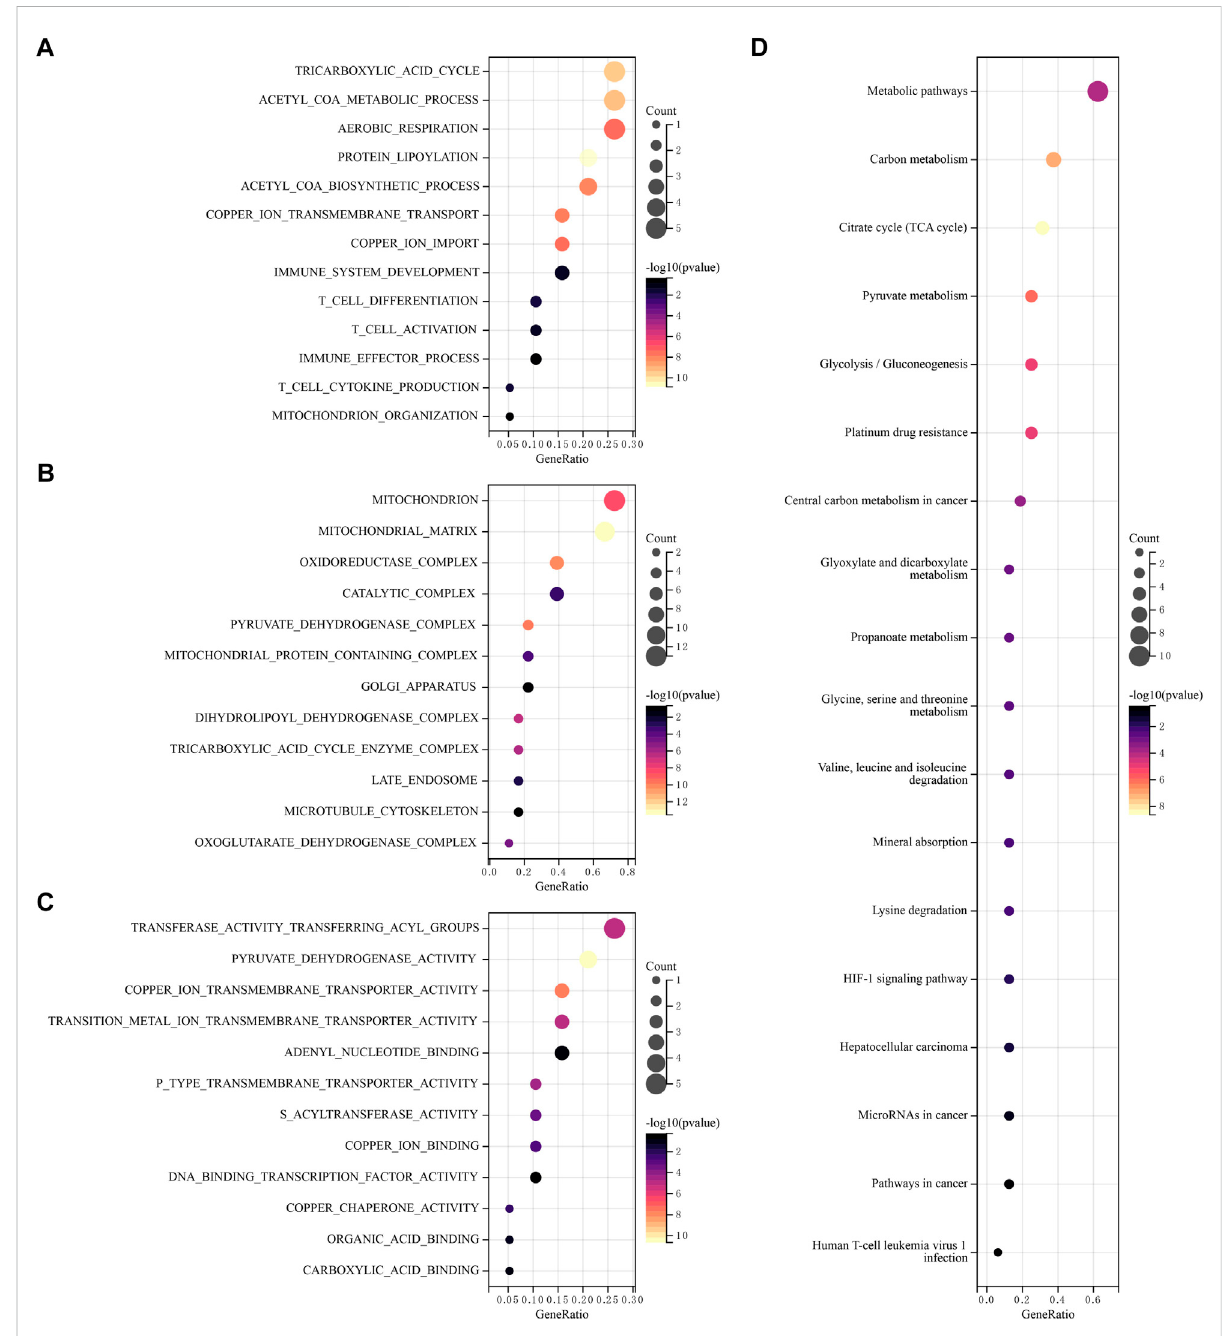
FIGURE 3 Functional enrichment analysis of CRGs. The enriched item in gene ontology analysis. (A) BP, (B) CC, (C) MF. (D) The enriched item in Kyoto Encyclopedia of Genes and Genomes